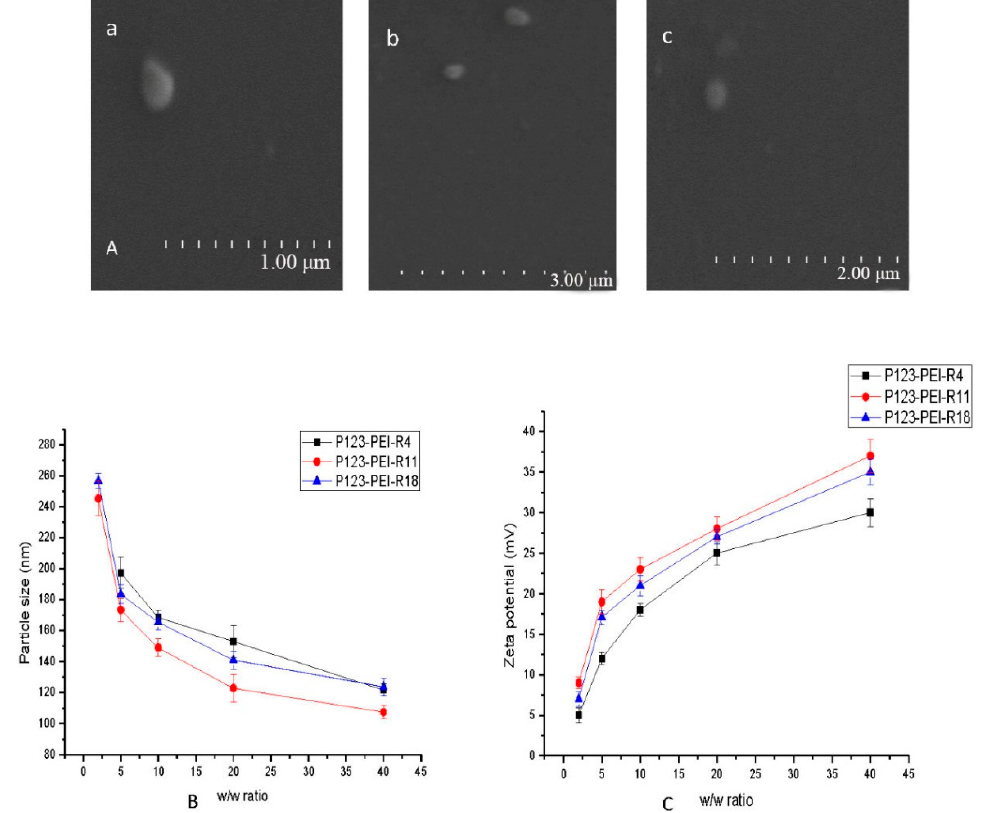
Figure 3. Representative TEM images of P123-PEI-R4/DNA ( a ), P123-PEI-R11/DNA ( b ) and P123-PEI-R18/DNA ( c ); ( B ) Particle size of P123-PEI-R4/DNA, P123-PEI-R11/DNA and P123-PEI-R18/DNA at various polymer-to-pDNA w / w ratios; ( C ) Zeta potential (mV) of P123-PEI-R4/DNA, P123-PEI-R11/DNA and P123-PEI-R18/DNA at various polymer-to-pDNA w / w ratios.